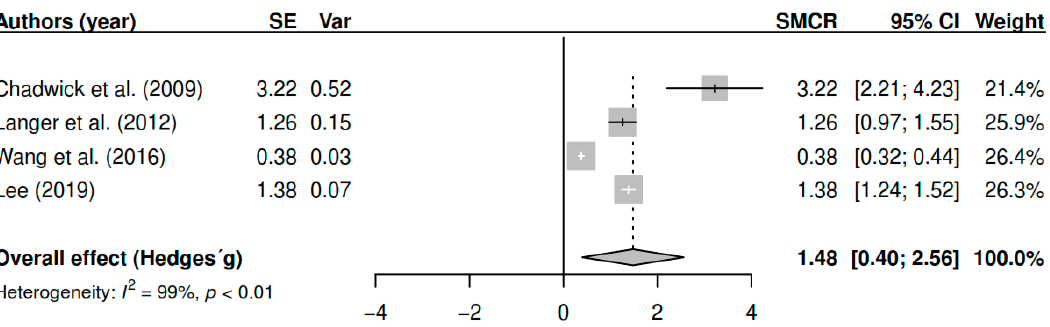
Figure 6. Forest plot for the model of random-effects and the values of Hedges’ g statistics in the mindfulness variable (pretest–posttest).